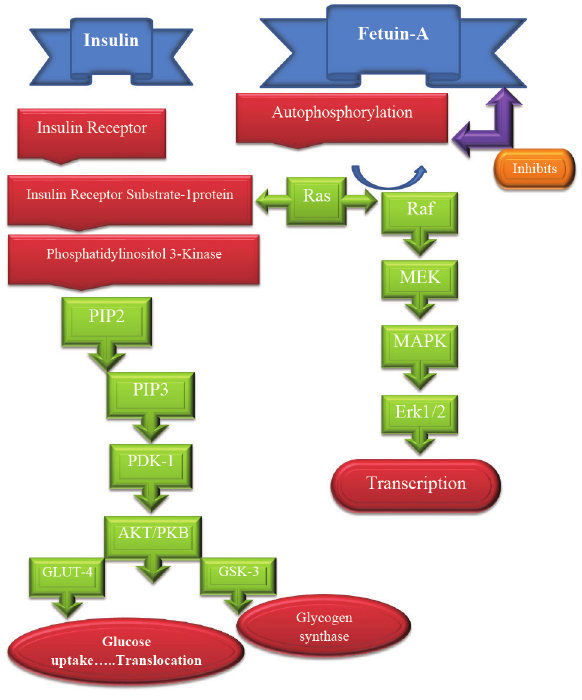
Figure 1 . Fetuin-A inhibits the tyrosine-kinase function of insulin receptor and this causes a prevention in its activity. Abbreviations: Renin–angiotensin system (RAS); Phosphatidylinositol 4,5-bisphosphate (PIP2); phosphatidylinositol (3,4,5)-trisphosphate (PIP3); Protein kinase B (PKB); a serine/threonine-specific protein kinase (AKT); Pyruvate dehydrogenase lipoamide kinase